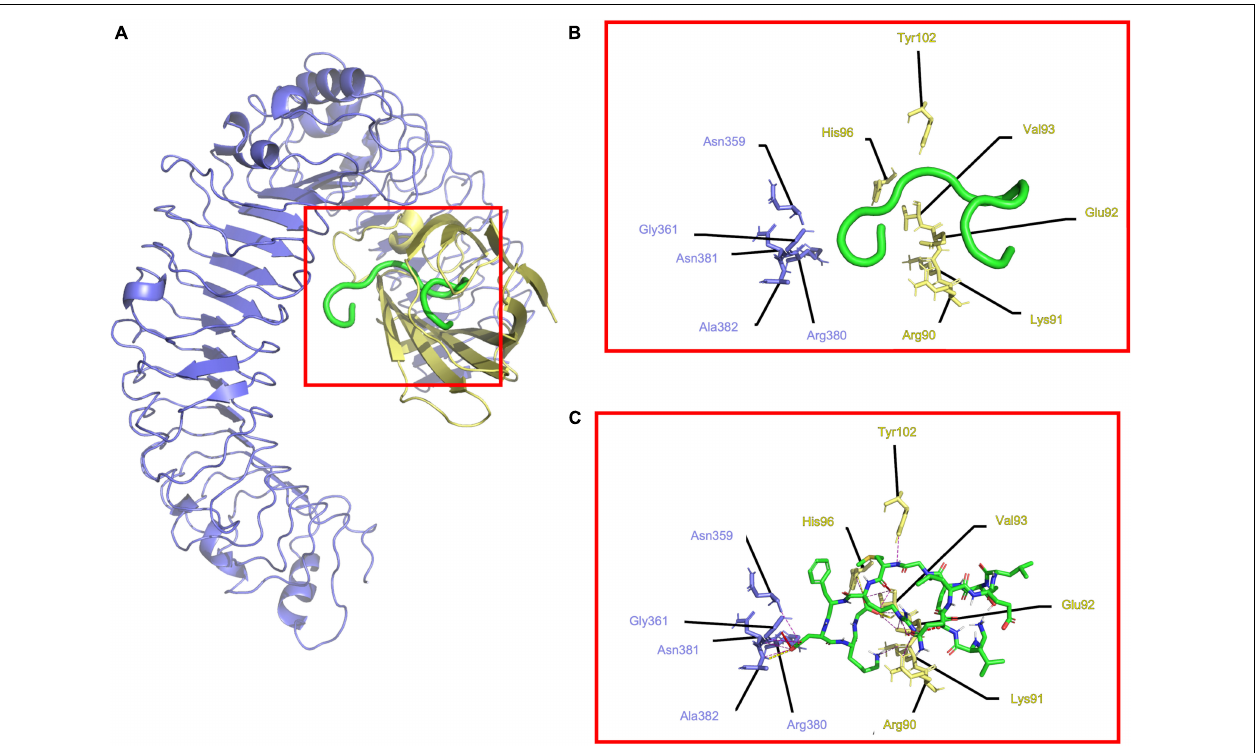
FIGURE 3 | Determined interactions between Peptide-2 and mTLR4/MD2. (A) General view of Peptide-2 (red) docked into mTLR4/MD2 (TLR4 is shown in purple and MD2 in yellow). (B) Detailed residues interacting with Peptide-2 colored in a segment belonging manner. (C) Detailed interactions occurring between residues and Peptide-2 (showed in a licorice representation with carbon atoms in green, oxygen atoms in red, hydrogen atoms in white, and nitrogen atoms in blue), hydrogen bonds are shown as a yellow dashed line, electronic clashes in a red dashed line, and electrostatic interactions in a magenta dashed line. All images were obtained with PyMOL and interactions identified with the ShowContacts